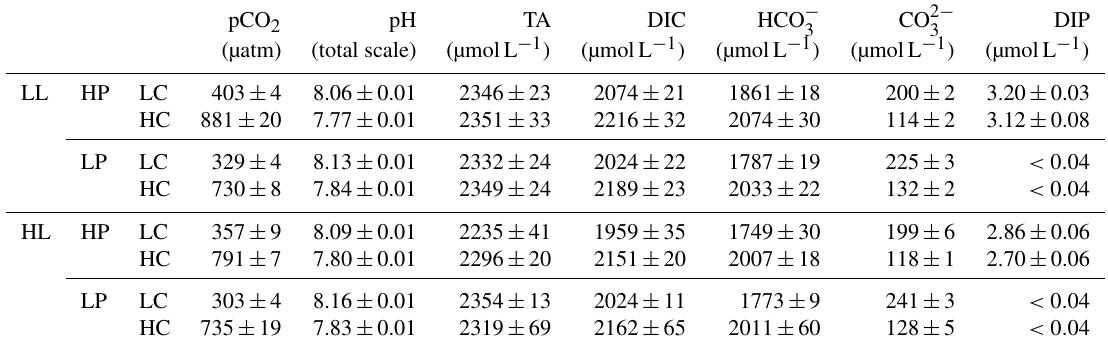
Table 1. Carbonate chemistry parameters and dissolved inorganic phosphorus (DIP) concentration at the end of the incubation. The values are means ± standard deviation (SD) of four replicates. Respectively, LL and HL represent 40 and 300µmolphotonsm − 2 s − 1 of photosyn- thetically active radiation (PAR), and HP and LP represent 4 and 0.43µmolL − 1 PO 3 − at the beginning of the incubations. 4 pCO